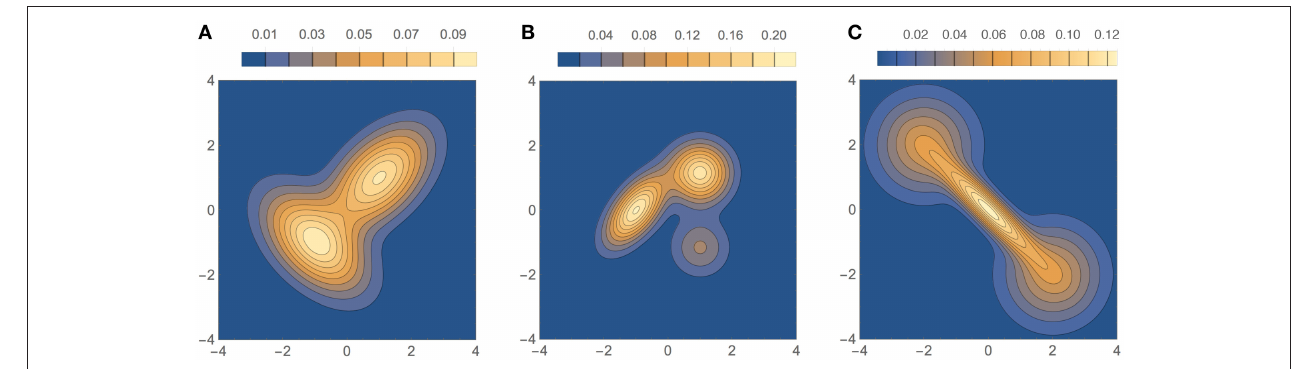
FIGURE 9 | Test densities (Gaussian mixtures) used in our bivariate simulation study. (A) F2 (bimodal); (B) F3 (trimodal); (C) F4 (dumbbell unimodal).